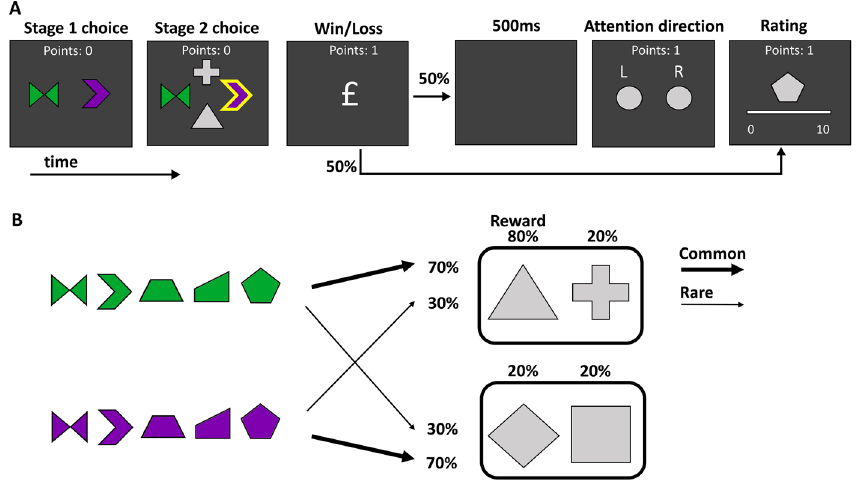
Figure 1. Structure of the task. ( A ) Participants chose one of two coloured shapes, which led to a second decision between one of two pairs of grey shapes. At any particular time one of these grey shapes was most likely to be rewarding. On half of trials participants were asked to remember back to their stage 1 choice to recall if the shape chosen was on the left or right side of the screen. On the other half of trials participants proceeded directly to the shape ratings screen, where participants rated how likely stage 1 shapes were to be rewarding at that time. ( B ) The probabilistic relationship between stage 1 colour and stage 2 shapes. Colour alone determined the transition probabilities to stage 2 pairs. The five stage 1 shapes were randomly presented and were outcome- irrelevant, making them a useful conduit for the passive accumulation of value over time. During a 32-trial block, one of the four grey shapes was most likely to be rewarding, in this case the